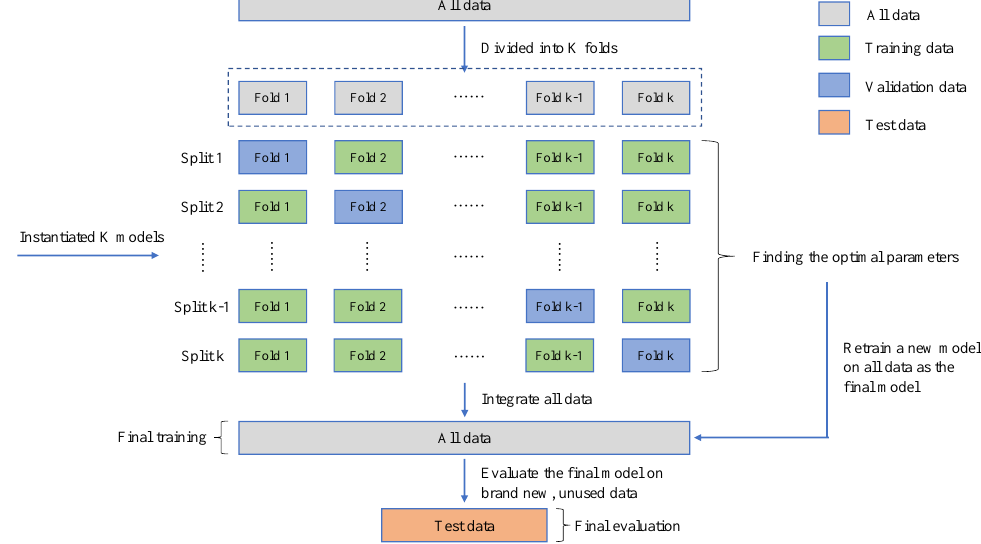
Figure 3. Schematic diagram of the K-fold cross-validation.